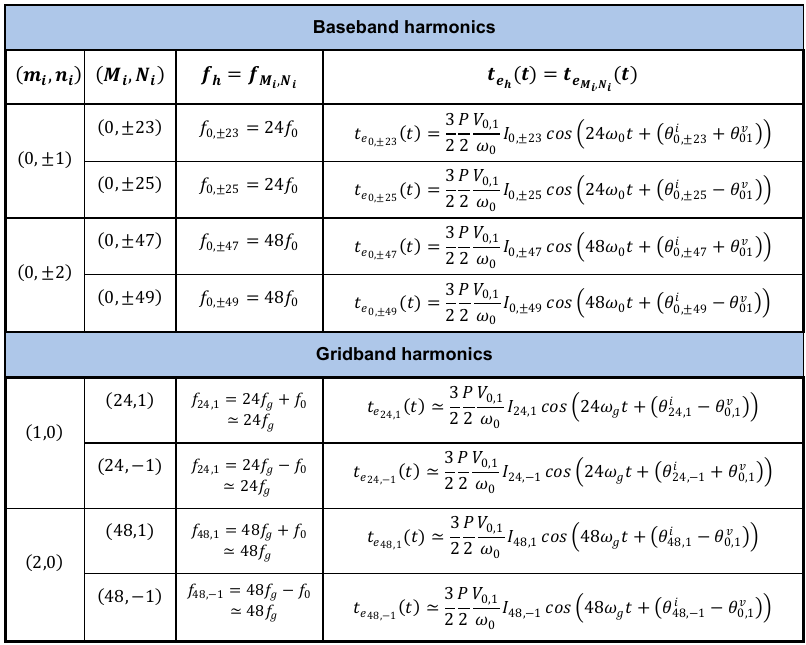
Figure 8. Harmonic families in a 12/12-pulse LCI system: sideband families.